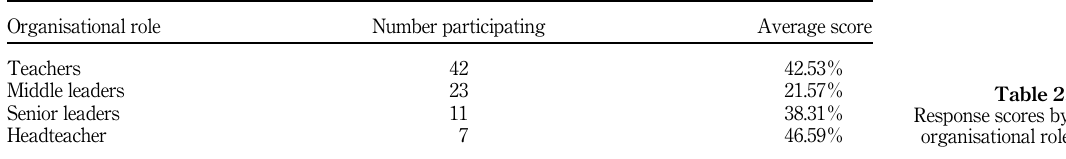
Table 2. Response scores